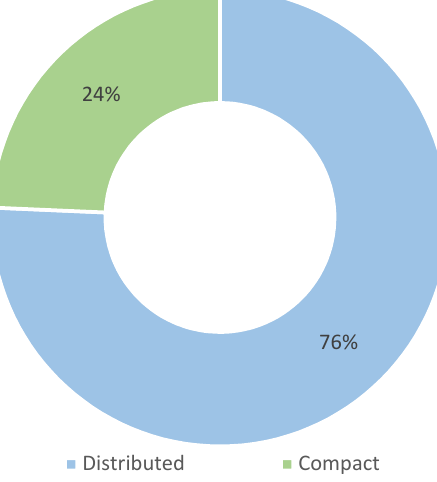
Figure 9. BMF system architecture.